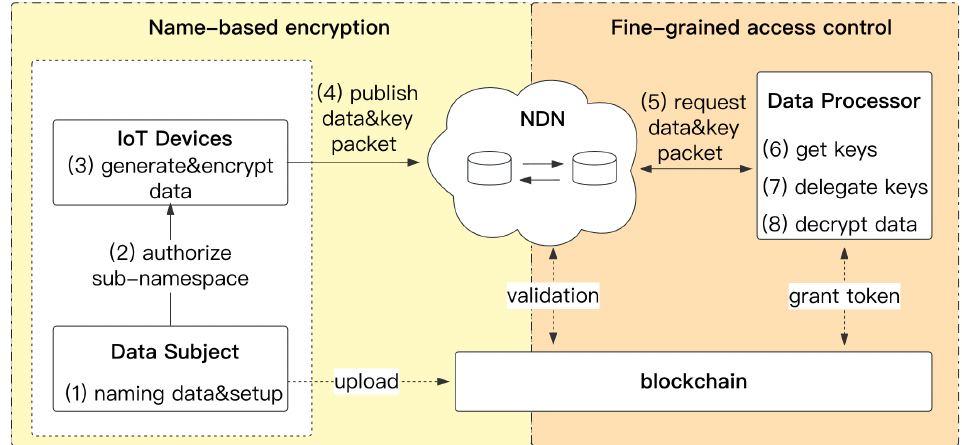
Figure 4. Name-based access control